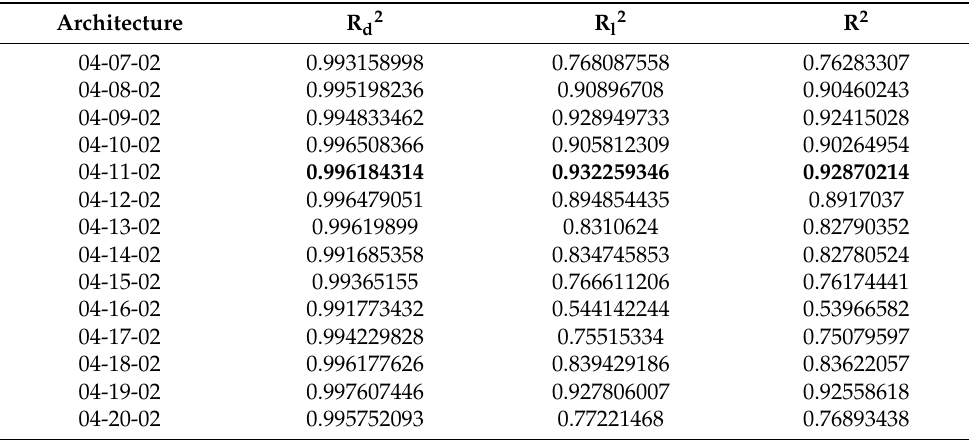
Table 2. Results of optimal ANN